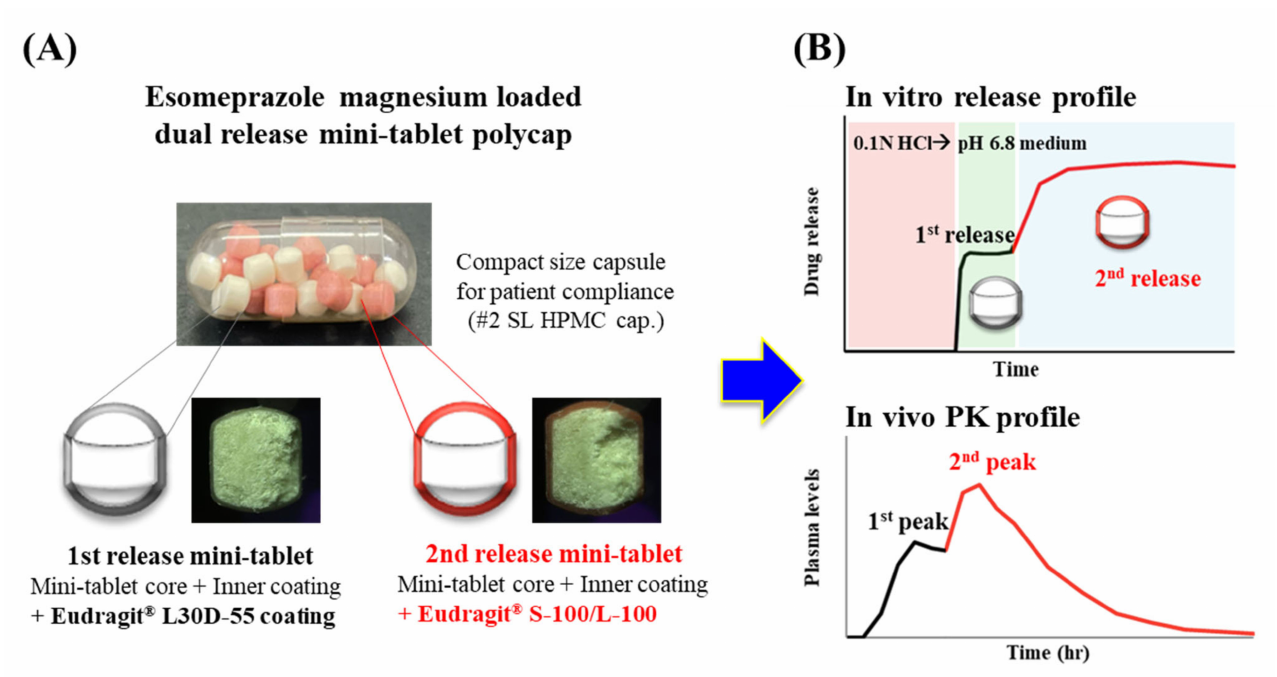
Figure 1. Schematic diagram of esomeprazole magnesium dual release mini-tablet polycap (DR polycaps). ( A ) image of DR polycaps. ( B ) In vitro release and in vivo pharmacokinetics profile of DR